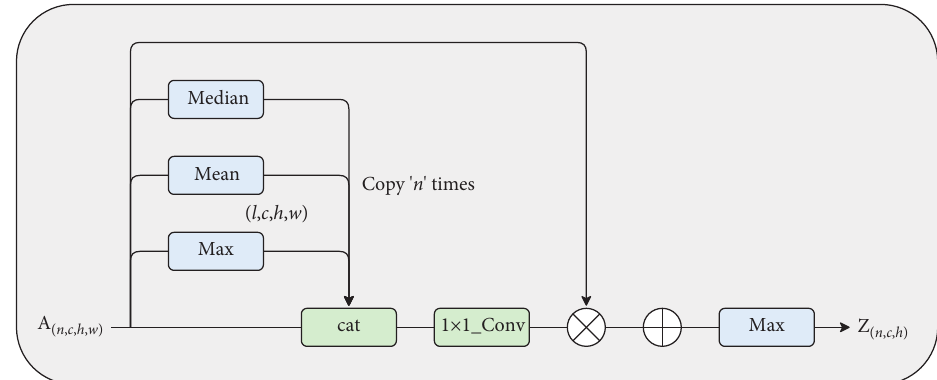
Figure 3: Attention mechanism in the set pooling pipeline. Matrix multiplication and addition are